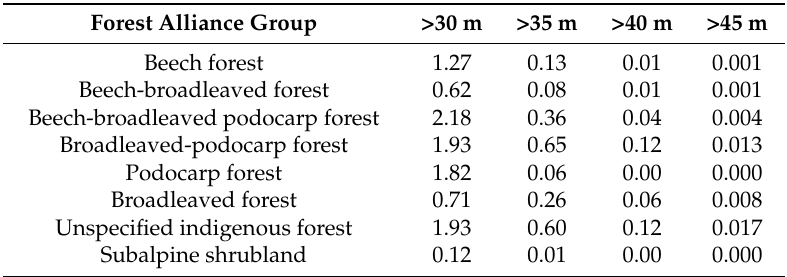
Table 5. Mean elevation of trees (m) in height classes.